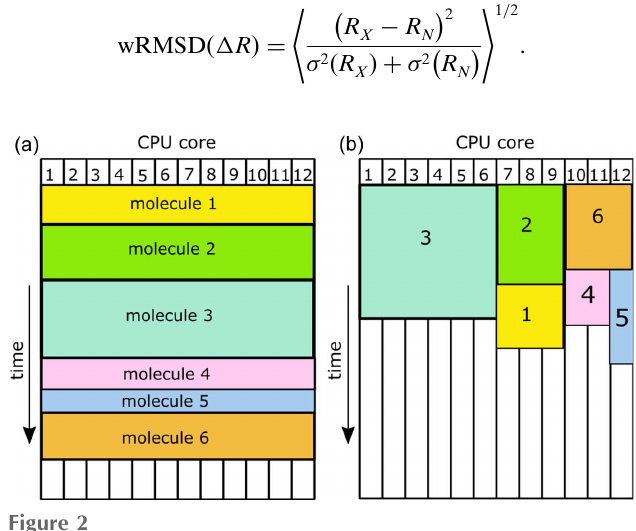
Figure 2 CPU core assignment ( a ) without and ( b ) with load-balancing.